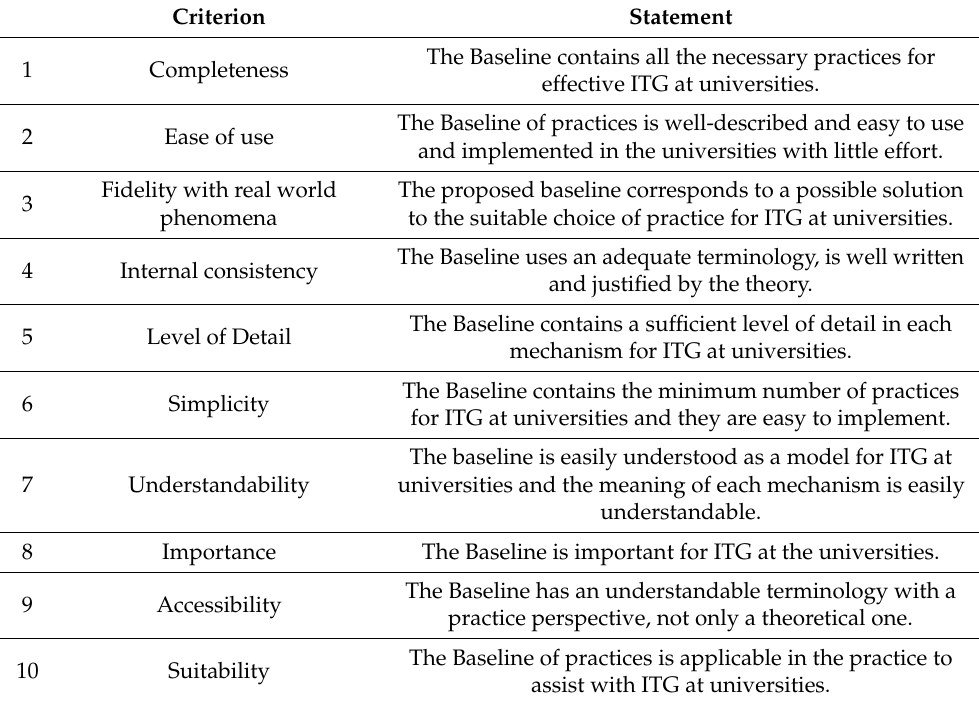
Table 4. Questionnaire for Evaluation of the IT Governance Practices’